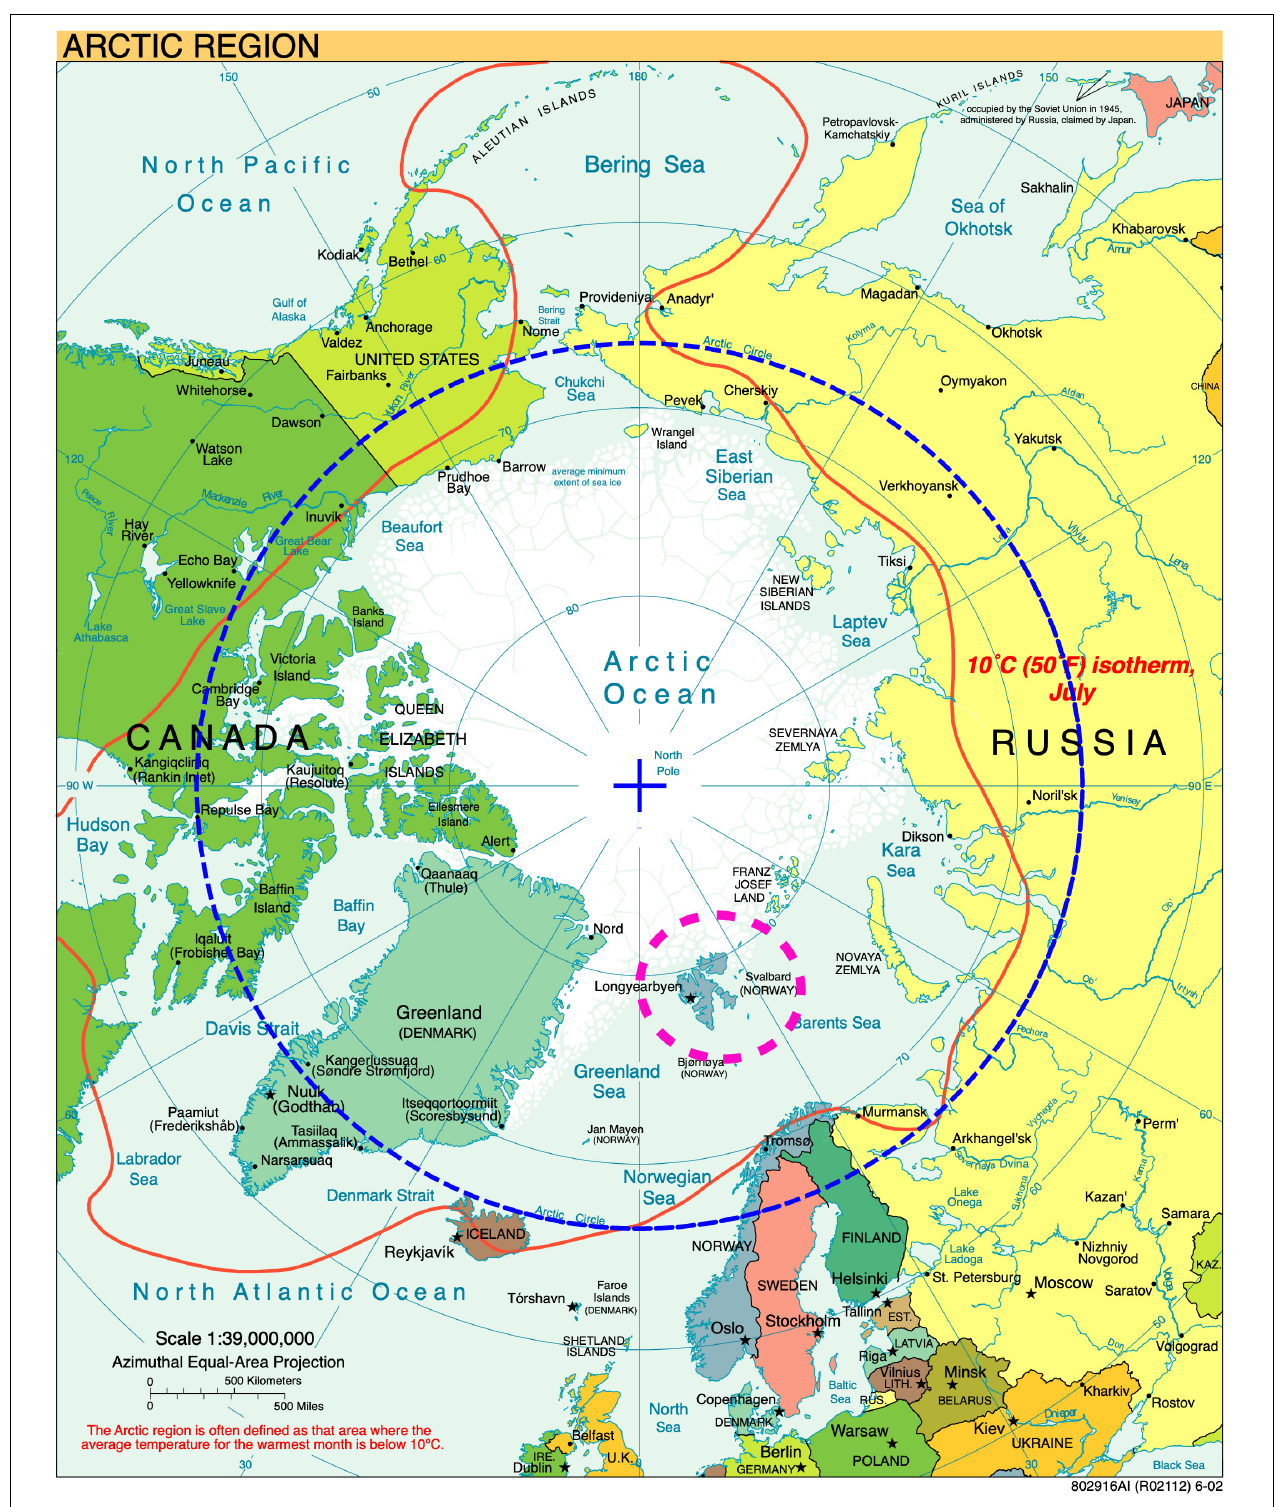
FIGURE 1 | Map of the Arctic Region. The Svalbard archipelago is outlined in the pink hashed circle, and Longyearbyen (Longyear City) indicated. Public domain source: https://commons.wikimedia.org/wiki/File:Arctic_circle.svg.